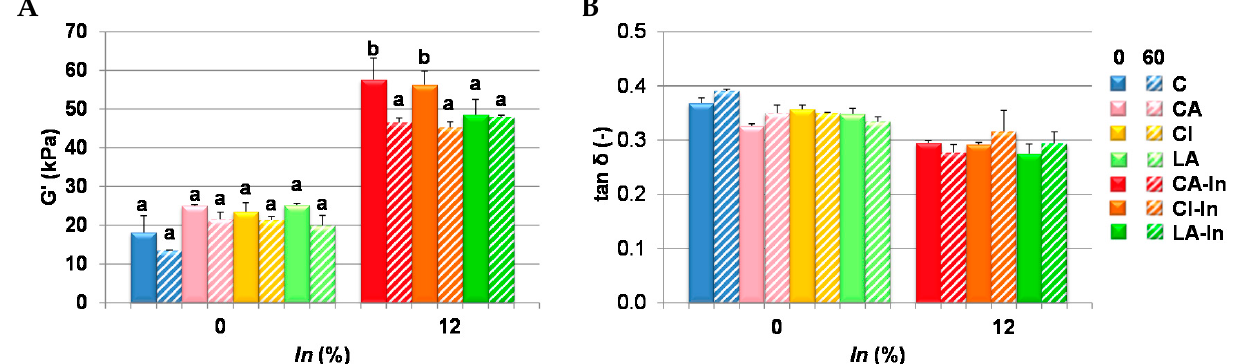
Figure 3. Rheological properties. ( A ) Elastic modulus (G ′ ) and ( B ) loss tangent (tan δ ) of fresh and stored doughs at − 18 ◦ C for 60 days. Different letters in the same formulation indicate significant differences ( p < 0.05). Bars: mean ± standard deviation; (-): unitless parameter. The value of G (cid:48) did not change during storage in the doughs without inulin. This parameter significantly decreased with the storage time in doughs containing carbonate and citrate and inulin (CA-In and CI-In), and remained unaltered in doughs with lactate (LA-In). This suggests a protective effect of lactate anion against matrix de-structuring. No significant differences were found in tan δ after storage for any of the doughs studied (Figure 3B), therefore freezing did not produce changes in dough viscoelasticity after storage for 60 days at − 18 ◦ C. Similar results were found in dough with strong breadmaking wheat flours